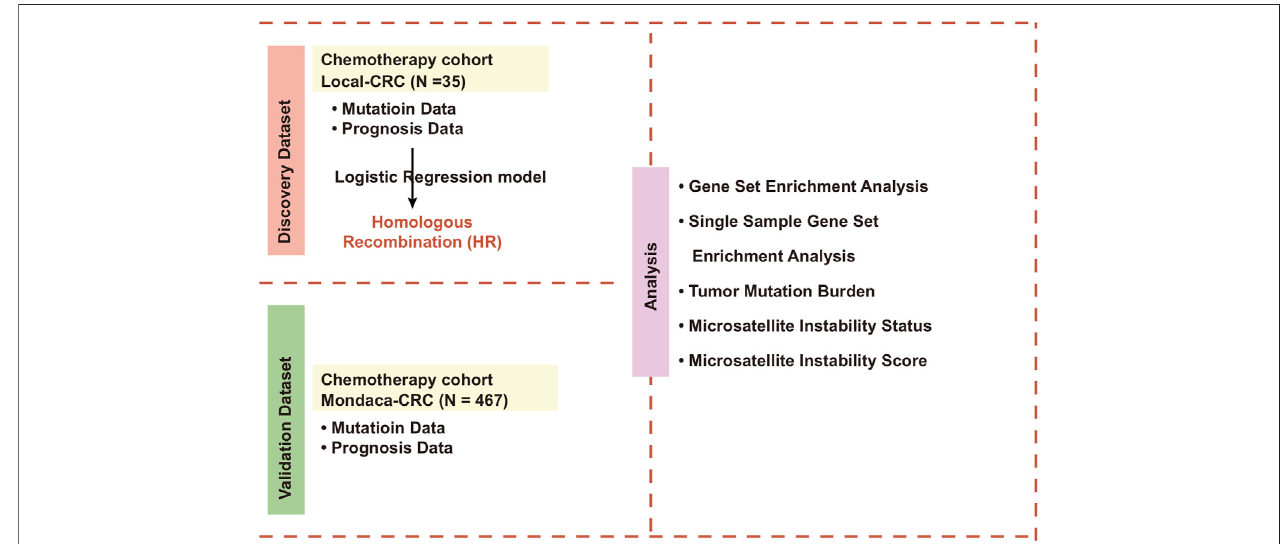
FIGURE 1 | Overall design of the